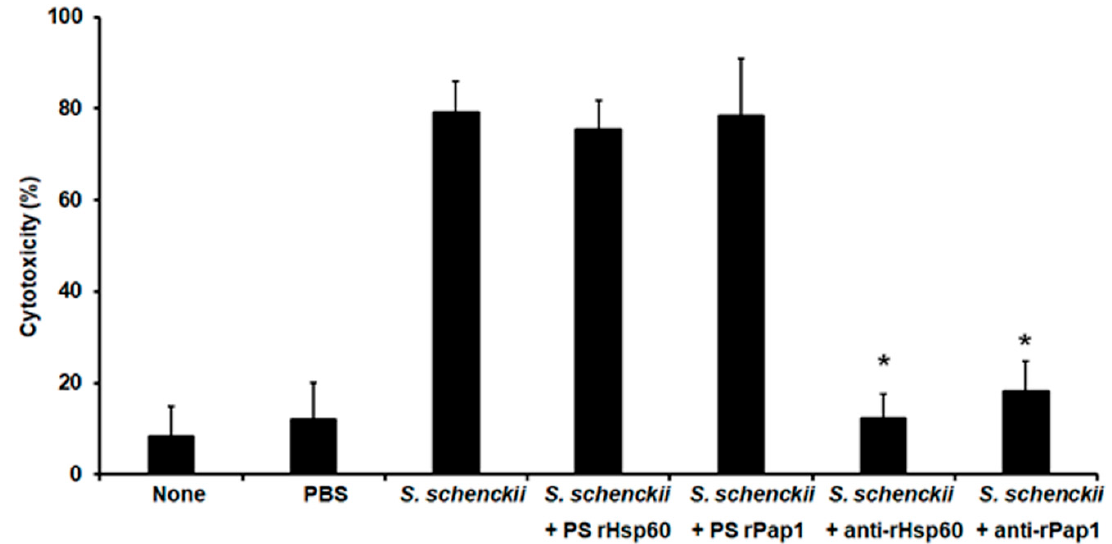
Figure 8. Effect of anti-recombinant Hsp60 and Pap1 antibodies on the cytotoxicity associated with Galleria mellonella killed by Sporothrix schenckii. G. mellonella larvae were inoculated with phosphate-buffered saline (PBS), 1 × 10 5 yeast-like cells ( S. schenckii ), or fungal cells pre-incubated with pre-immune sera (PS) of hosts where anti-rHsp60 or anti-Pap1 antibodies were produced or pre-incubated with polyclonal anti-rHsp60 or anti-rPap1 antibodies ( S. schenckii + rHps60 and S. schenckii + rPap1, respectively), then incubated at 37 °C for 24 h, and the cell-free lactate dehydrogenase activity was quantified in the hemolymph. None, noninoculated animal group. Results are means ± SD of three independent experiments performed by duplicate. * p < 0.05 when compared to the animal group inoculated with S. schenckii with no pre-incubation. Collectively, these data strongly suggest that Hsp60 and Pap1 are proteins that con- tribute to the S. schenckii ’s ability to kill G. mellonella